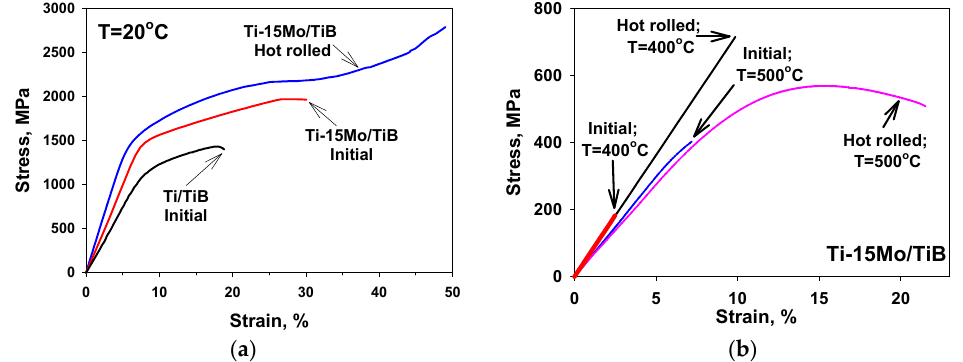
Figure 7. Stress–strain curves of Ti-15Mo/TiB composite in initial and hot rolled conditions tested ( a ) in compression at room temperature and ( b ) in tension at 400 or 500 °C. A typical stress–strain curve for hcp α Ti/TiB composite with the same volume fraction of TiB reinforcement is shown in ( a ) for comparison.